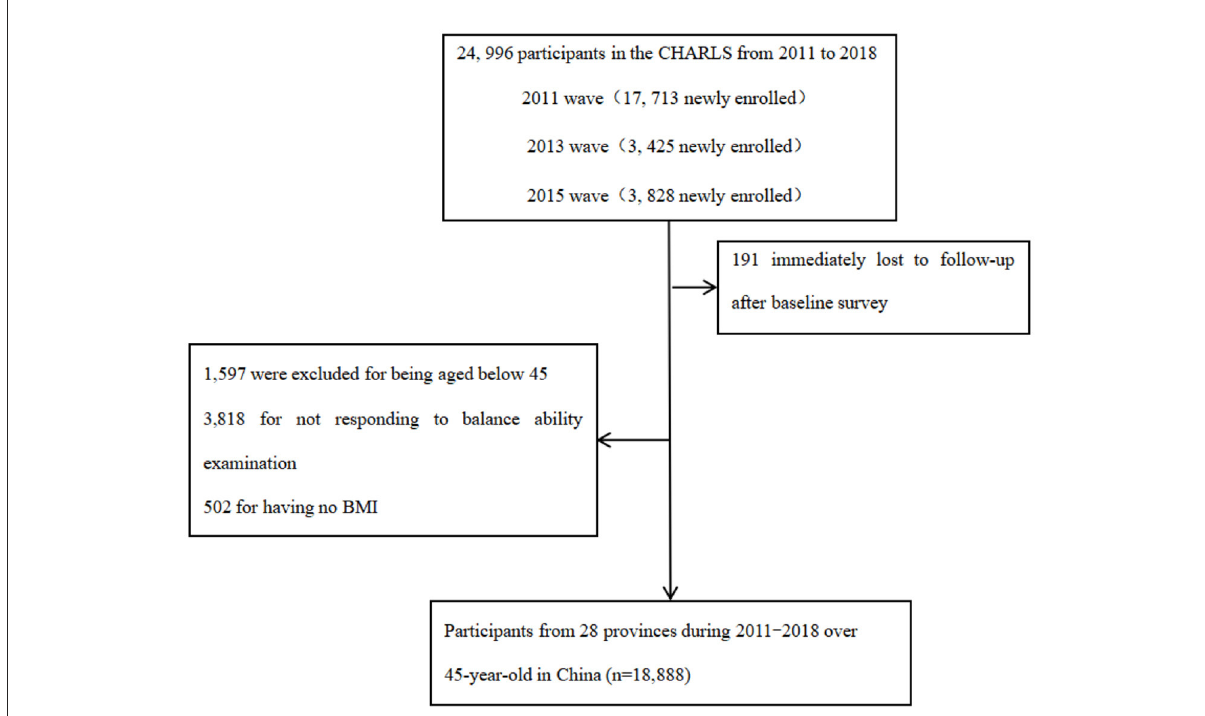
FIGURE1 Flowchart of sample